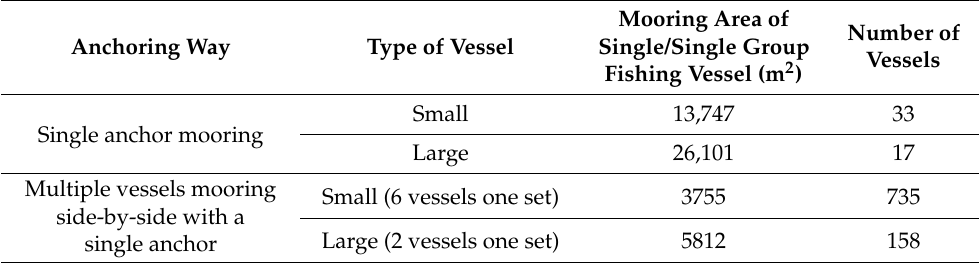
Table 2. Total number of vessels that can be berthed in SYFP during level 12–17 typhoons.